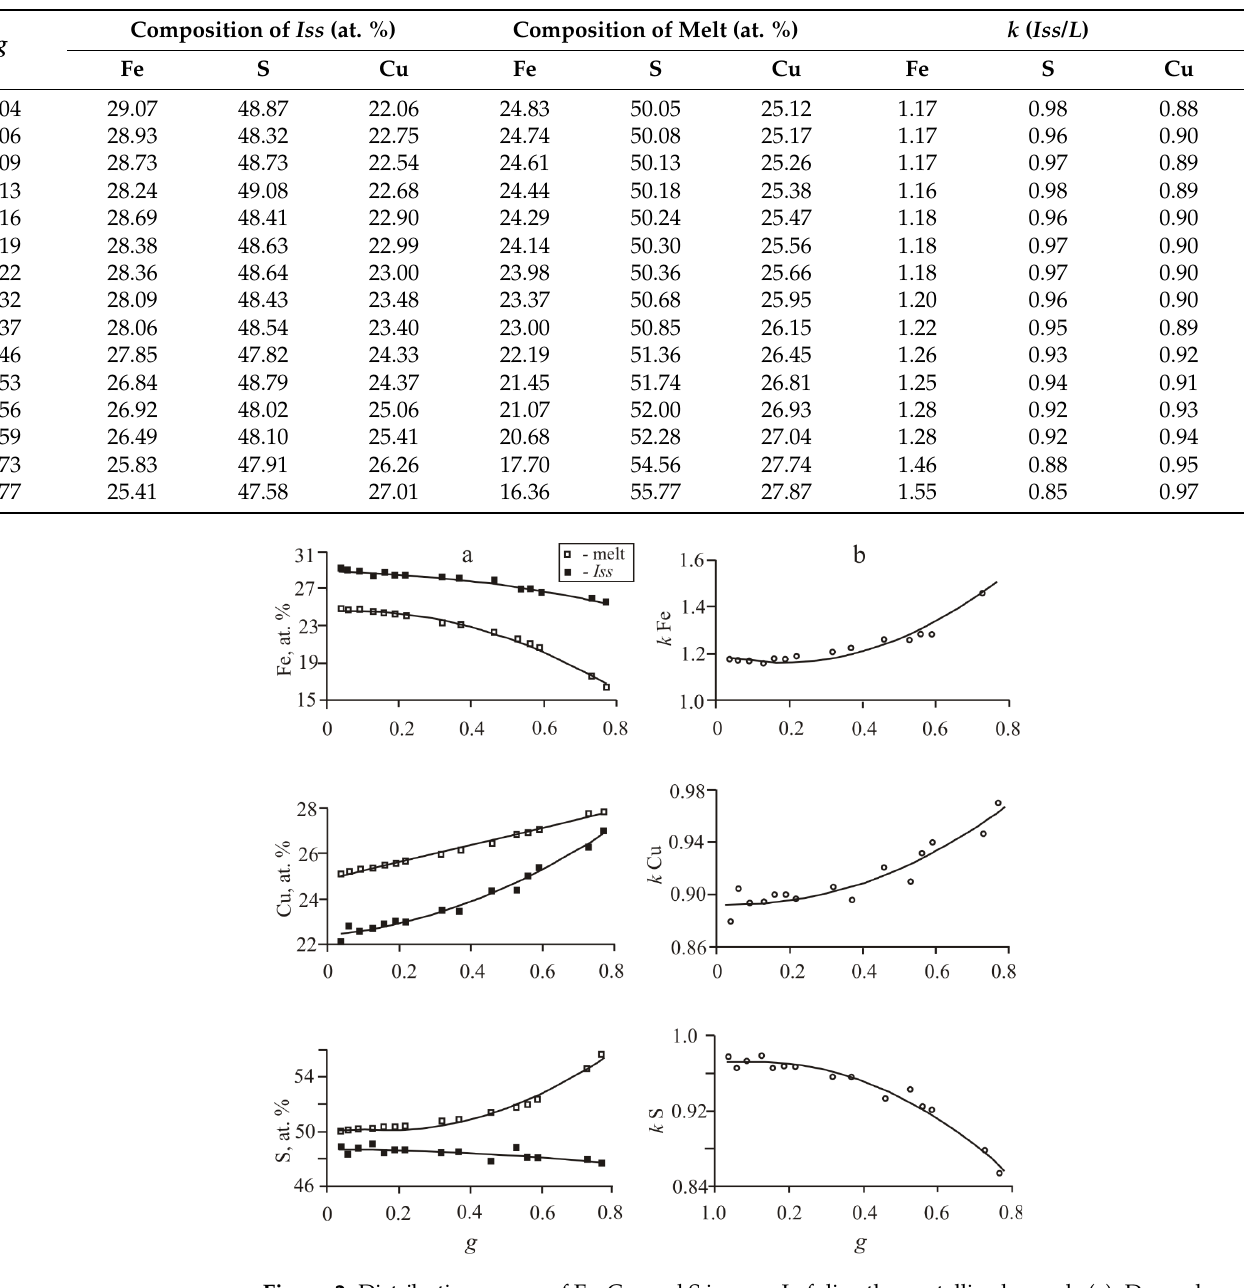
Table 1. Composition of Iss, L , and distribution coefficients of components between Iss and L ( k ) depending on the degree of crystallization ( g ).